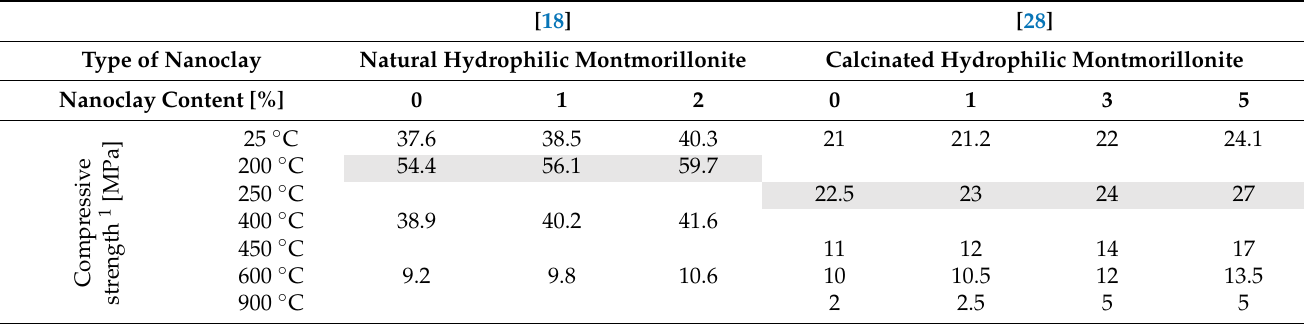
Table 4. Compressive strength values for nanoclay—mortar/concrete specimens at high temperature.